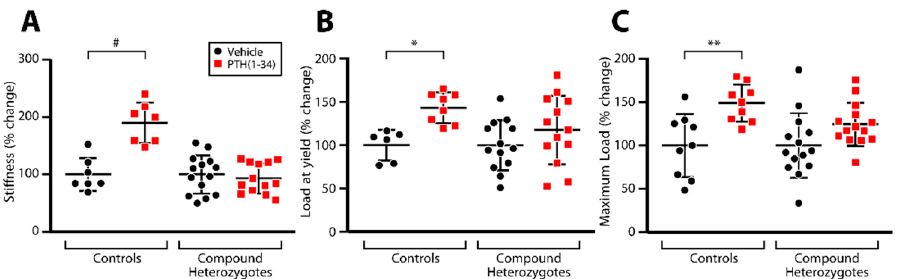
Figure 4. The increase in biomechanical properties induced by iPTH treatment is blunted in Naca / Lrp6 compound heterozygotes. Four ‐ month ‐ old female mice were treated once daily, 5 days/week for 1 month with 100 μ g/kg of PTH(1 ‐ 34). L2 vertebrae were analyzed by compression testing to measure stiffness ( A ), load at yield ( B ) and maximum load ( C ). Results are expressed as change from vehicle ‐ treated animals, which are ascribed a value of 100%. * p < 0.05; ** p < 0.01; # p < 0.0001, two ‐ way analysis of variance (ANOVA) with post hoc tests.